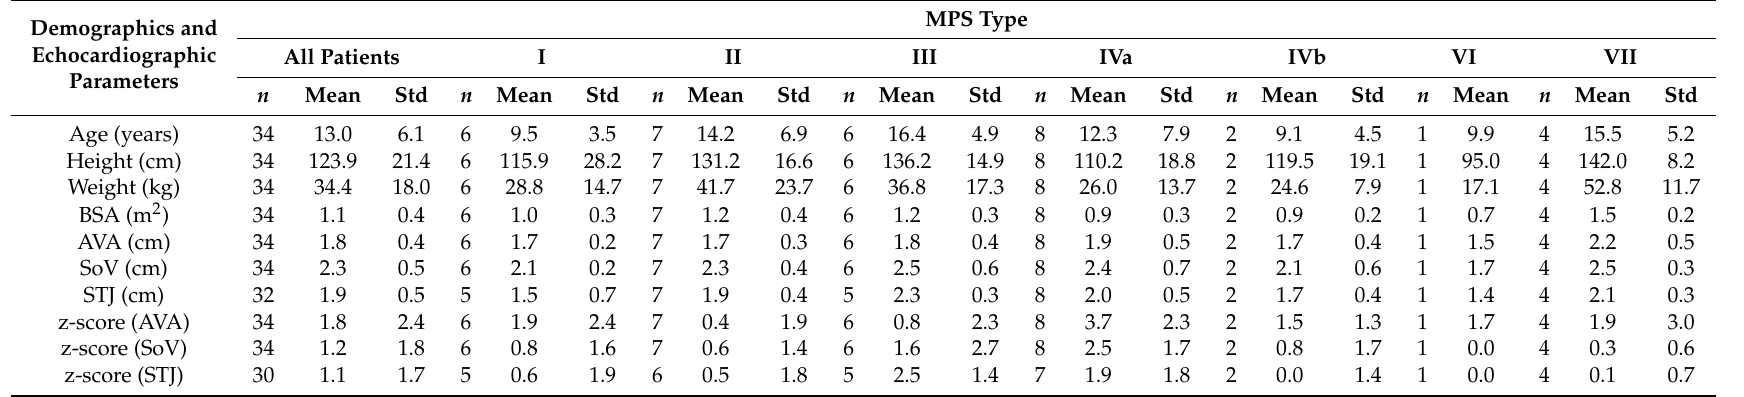
Table 1. Patient demographics: the age refers to the age of the patient at the time of his or her latest echocardiogram. BSA = body surface area, AVA = aortic valve annulus, SoV = sinuses of Valsalva, Std = standard deviation. STJ = sinotubular junction. Demographics and